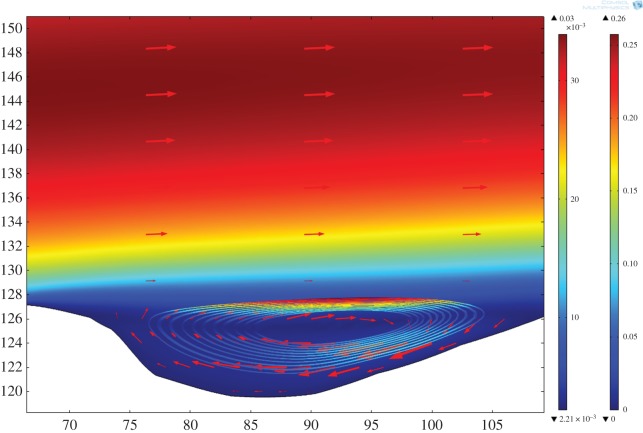
Eddy structure formed at the lower margin of the Sill. Streamlines define the particle orbital trajectory (density 2200 kg m−3); arrows show fluid motion. Magma viscosity 10 Pa s, density 2500 kg m−3.